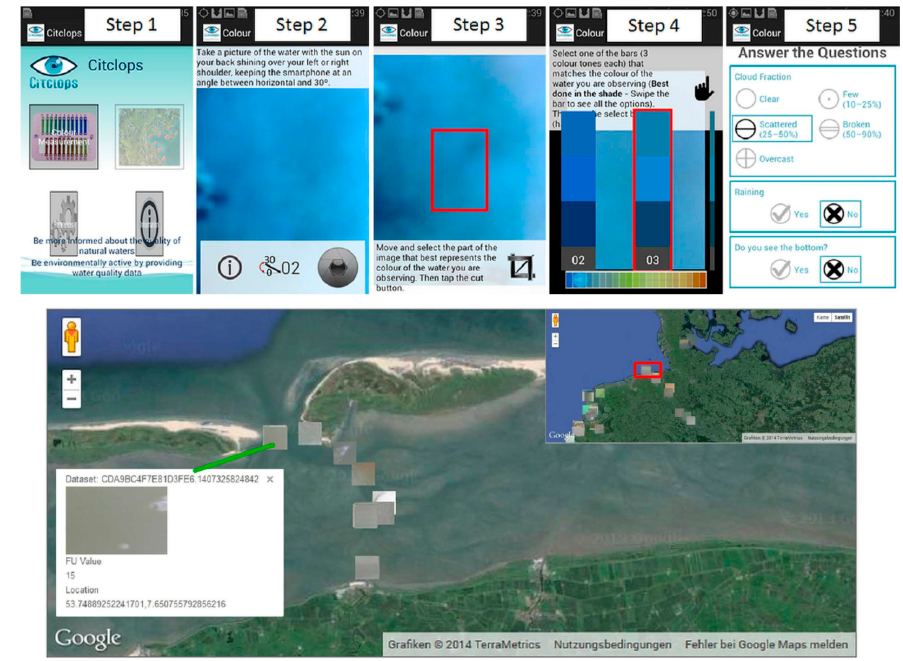
Figure 7. Screenshots of the smartphone app in use over an artificial water surface. Sampling steps: ( 1 ) open the app and select “Colour measurements”; ( 2 ) take a picture of the water surface within the given angle range and select the camera shutter icon; ( 3 ) crop out the part of the images that best represents the apparent colour of the local water surface; ( 4 ) match the cropped out image to the colour bar and ( 5 ) complete the short questionnaire and send the data.